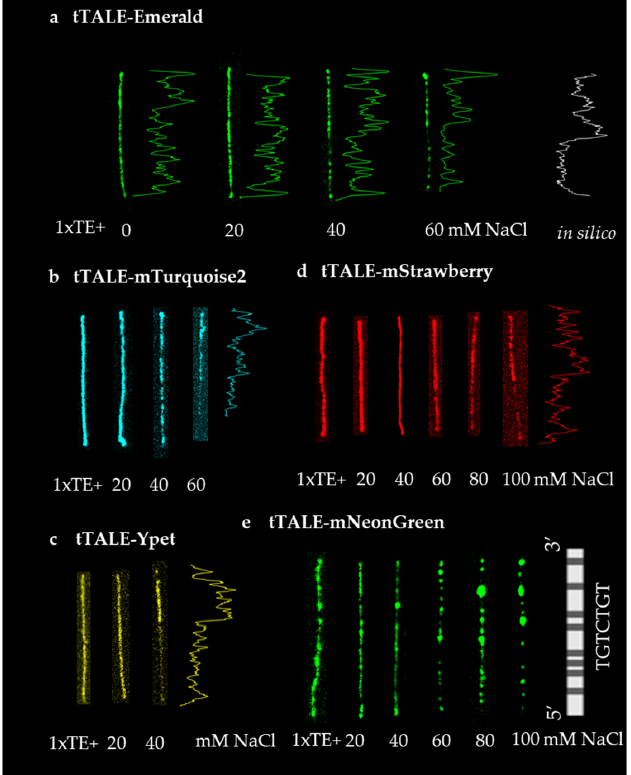
Figure 4. tTALE-FP staining of λ Phage DNA for A/T specific map. ( a ) λ Phage DNA was stained with 30 nM tTALE-Emerald. The fluorescence intensity profiles are shown along with the in silico profile of AT frequency. Stained images of ( b ) 40 nM tTALE-mTurquoise2 ( c ) 40 nM tTALE-Ypet ( d ) 30 nM tTALE-mStrawberry and an intensity profile were shown. A stained image of ( e ) 30 nM tTALE-mNeonGreen with in silico maps of TGTCTGT was shown. Fully stained DNA was treated with different concentrations of NaCl in 1 × TE buffer.